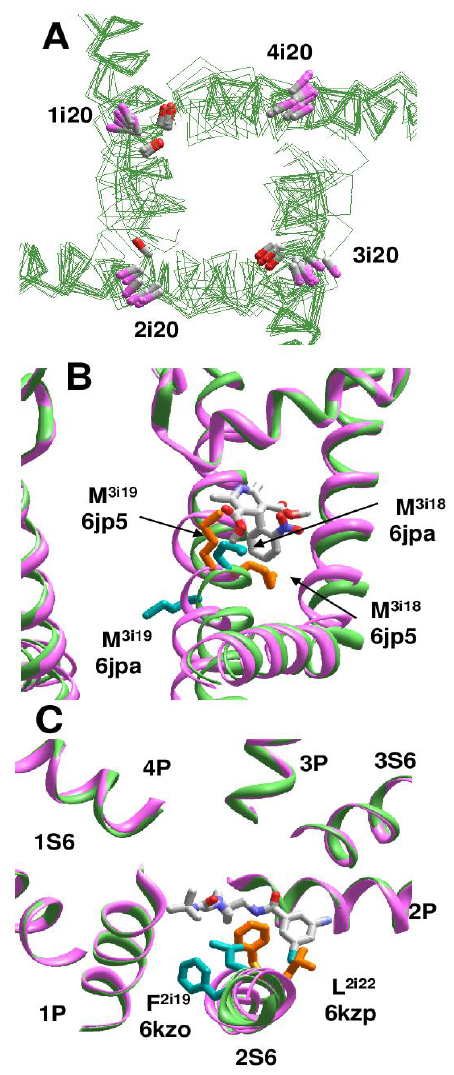
Figure 6. π -Bulges affect patterns of ligand-sensing residues in Cav1.1 channel. A , Diverse orientation of asparagines N i20 . Orientation of N i20 _C α -C β bonds in regular and π -bulged helices are shown with magenta and red CB atoms, respectively. B , Different orientation of adjacent M 3i18 and M 3i19 in Cav1.1 Class II structure (PDB ID: 6jp5, magenta backbone, orange sidechains) and Class III structure (PDB ID: 6jpa; green backbone, cyan sidechains). M 3i18 faces the DHP site in Class II structure, whereas M 3i19 faces the DHP site in Class III structure. C, Superimposition of Cav3.1 structures with Z944 (6kzp) and without Z944 (6kzo). Residues in matching positions 2i19 and 2i22 differently interact with the ligand since the π -bulge is present only in 6kzp.